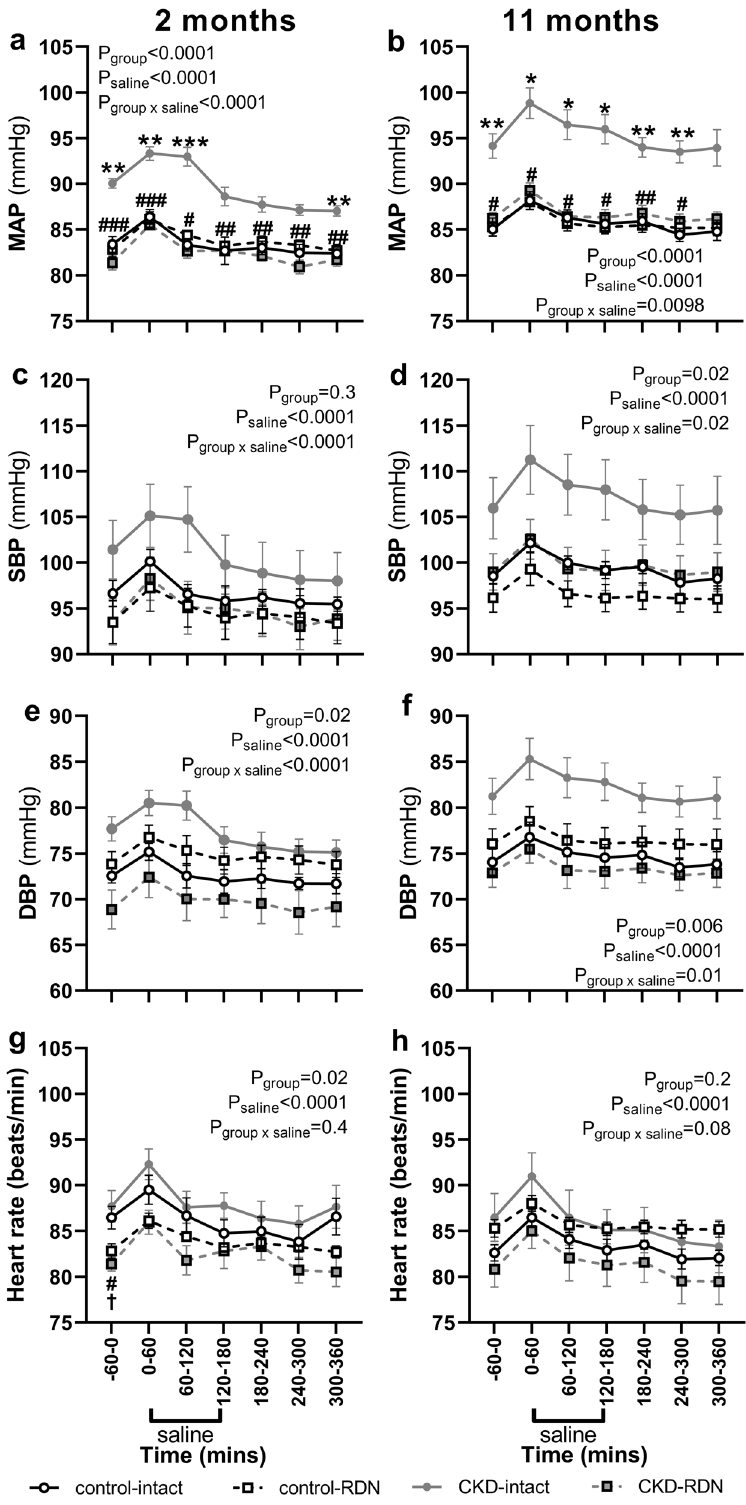
Figure 1. Arterial pressure and heart rate in response to isotonic saline loading. MAP; mean arterial pressure, SBP; systolic blood pressure, DBP; diastolic blood pressure. Data are at baseline; − 60–0 min, during 180 min of saline infusion and during 180 min of recovery post saline infusion. Responses were examined in normotensive and hypertensive CKD sheep at 2 and 11 months after sham (intact) or renal denervation (RDN) procedure. Data are mean ± SE. *P < 0.05, ***P < 0.001, ***P < 0.001 comparing control-intact with CKD-intact, # P < 0.05, ## P < 0.01, ### P < 0.001 comparing CKD-intact with CKD-RDN, † P < 0.05 comparing control-intact with control- RDN from post-hoc analysis following repeated measures